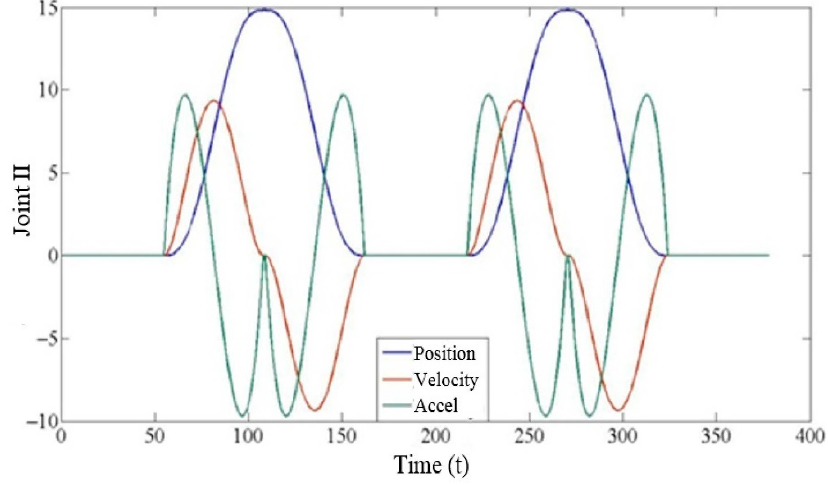
Figure 4. One joint movement [23].